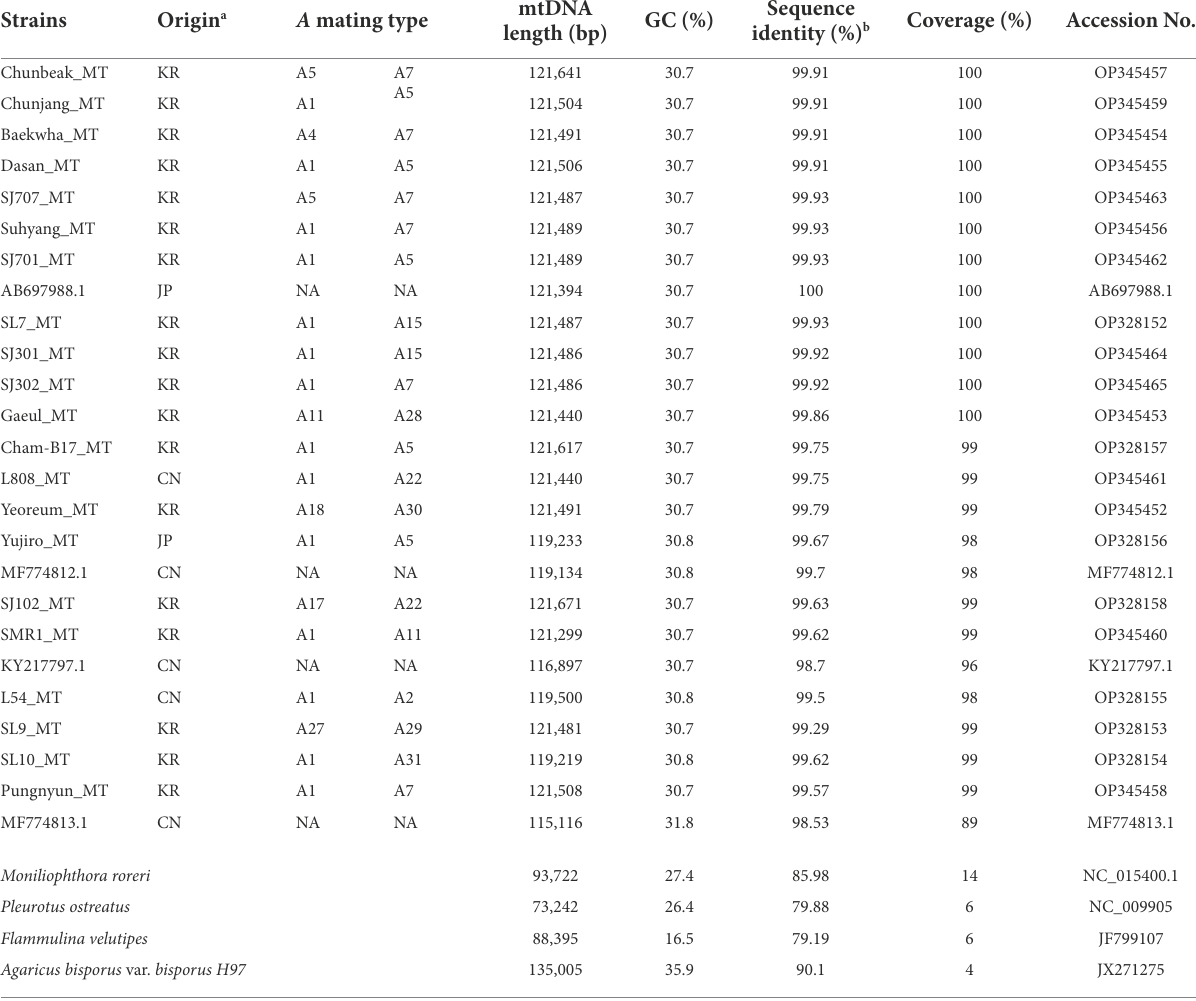
TABLE 1 Characteristics of mtDNAs of Lentinula edodes and some selected mushrooms.